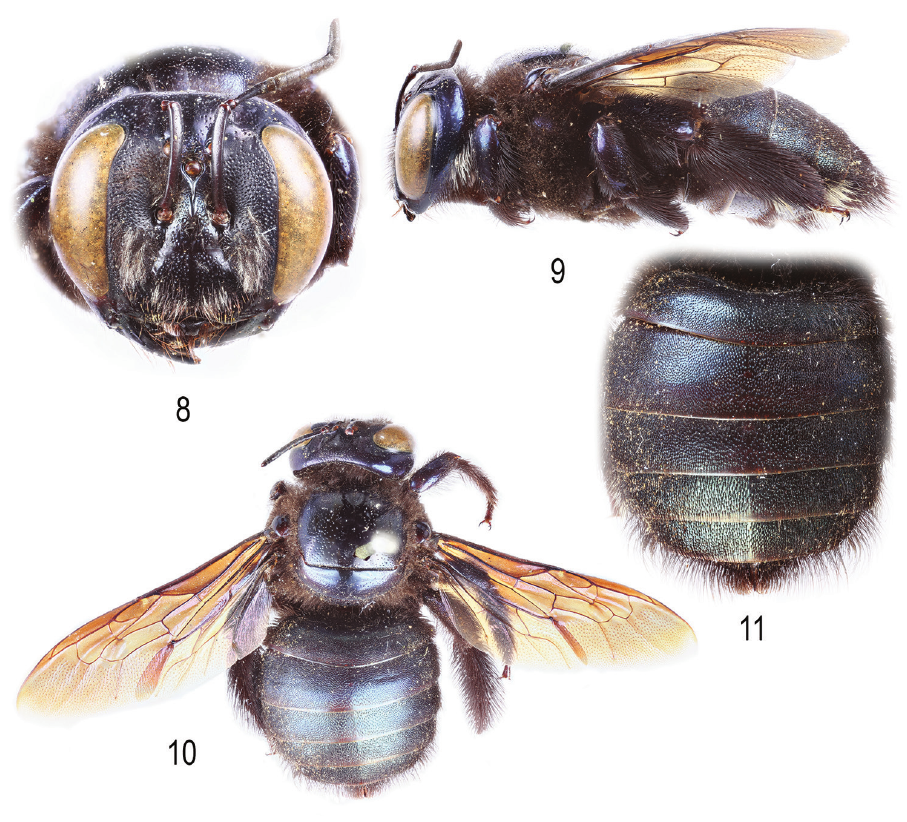
Figures 8–11. Female holotype of Xylocopa ( Schonnherria ) barbarae sp. n. 8 Facial view 9 Lateral habitus 10 Dorsal habitus 11 Detail of metasomal terga.